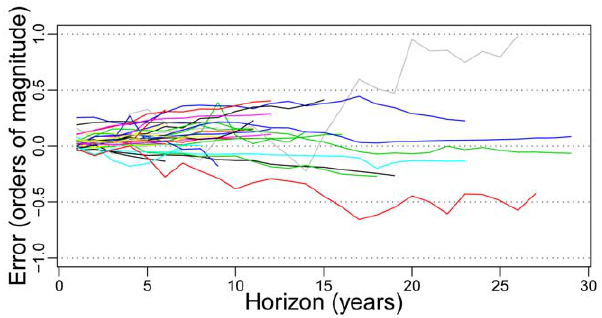
Figure 1. An illustration of the growth of errors with time using the Wright model. The mean value of the logarithmic hindcasting error for each dataset is plotted against the hindcasting horizon j { i , in years. An error of 10 0 : 5 & 3 , for example, indicates that the predicted value is three times as big as the actual value. The longest data-sets are: PrimaryAluminum (green), PrimaryMagnesium (dark blue), DRAM (grey), and Transistor (red).